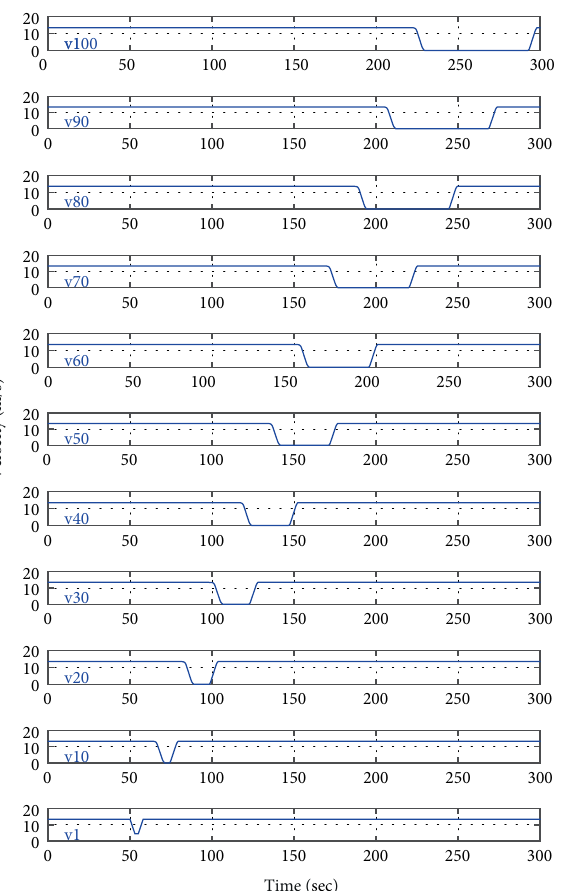
Figure 3: Velocity trajectories of 11 samples of vehicles.